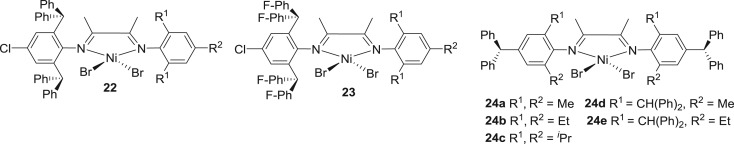
Fluorinated and non-fluorinated benzhydryl-containing unsymmetrical and symmetrical α-diimine-nickel pre-catalysts 22–24.